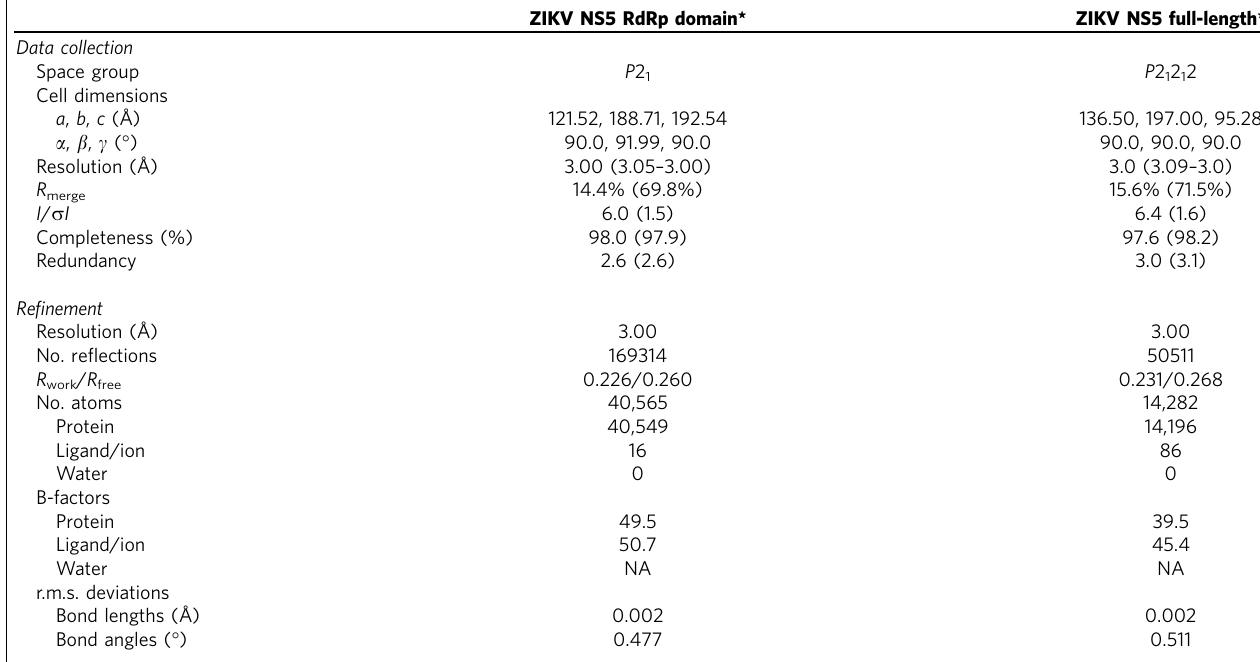
Table 1 | Statistics of crystallographic